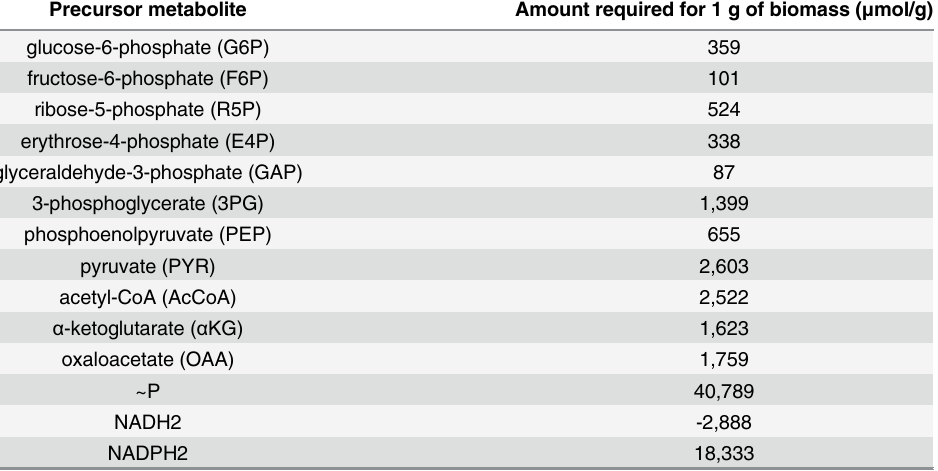
Table 2. Intermediate metabolites and energy requirements for the formation of 1 g of biomass during exponential growth [27].